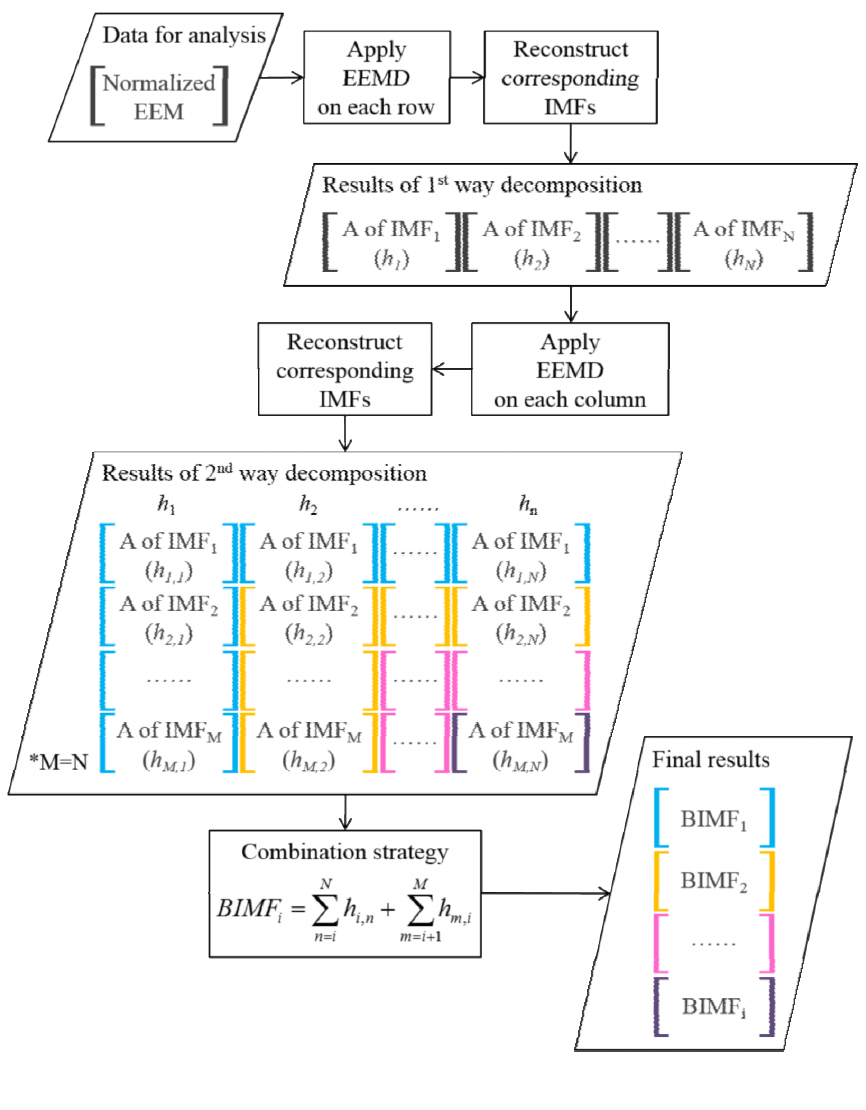
Figure 7. Multi-dimensional ensemble empirical mode decomposition (MEEMD)